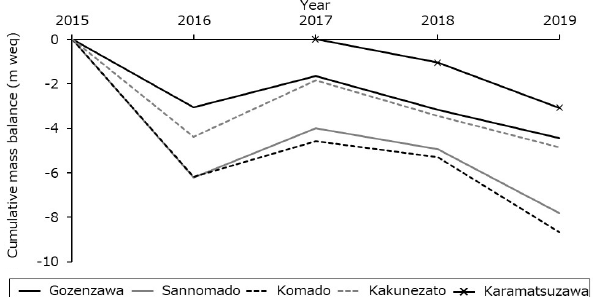
Figure 10. Cumulative mass balance of each glacier with baseline of 2015 (2017 for Karamatsuzawa).